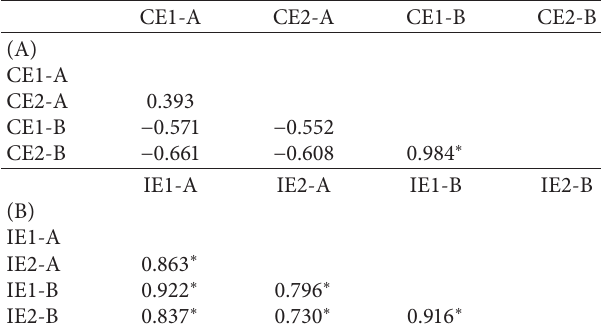
Figure 1: Mean heart rate values of each dog in continuous exercise in six W stages during protocols 1–6 (a) and protocols 7–12 (b). Mean heart rate values of each dog in the interval exercise in each R and W stages during protocols 1–6 (c) and protocols 7–12 (d). ∗ , a, b, c Significant differences when comparing the average heart rate of each stage in an individual. ∗∗ Significant differences ( P < 0 . 05) in the mean heart rate between individuals at the same stage of the same Table 4: Correlation between individual heart rate and exercise intensity during continuous exercise or interval exercise.